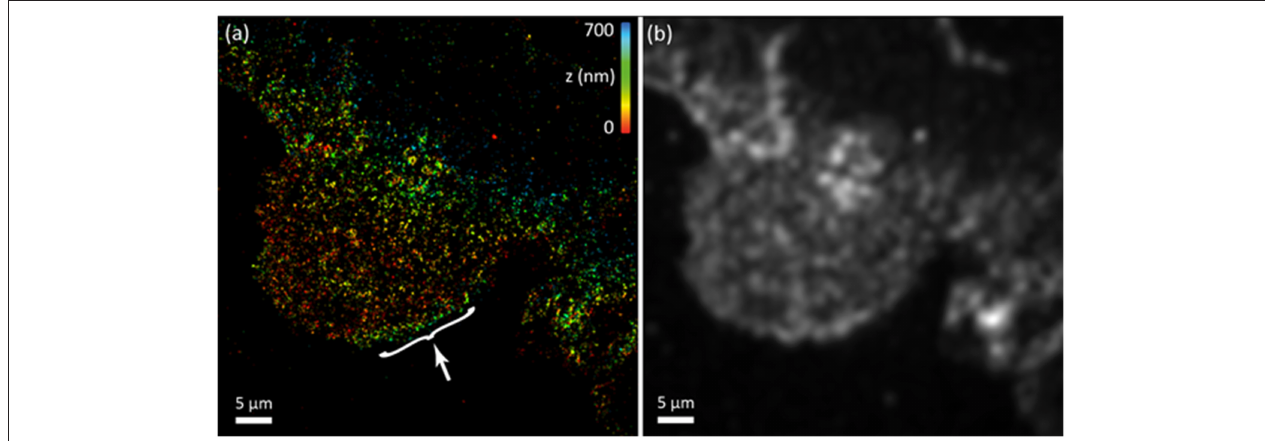
FIGURE 2 | uPAINT-based super-resolution imaging of EGF receptors in living A431 adherent cells. (a) Single molecule based 3D super-resolved reconstructed image. The nano-topography of the cell is clearly visible. The white arrow indicates membrane ruffling linked to an increase in height at the edge of the cell. (b) Computer generated epi-fluorescence image (diffraction